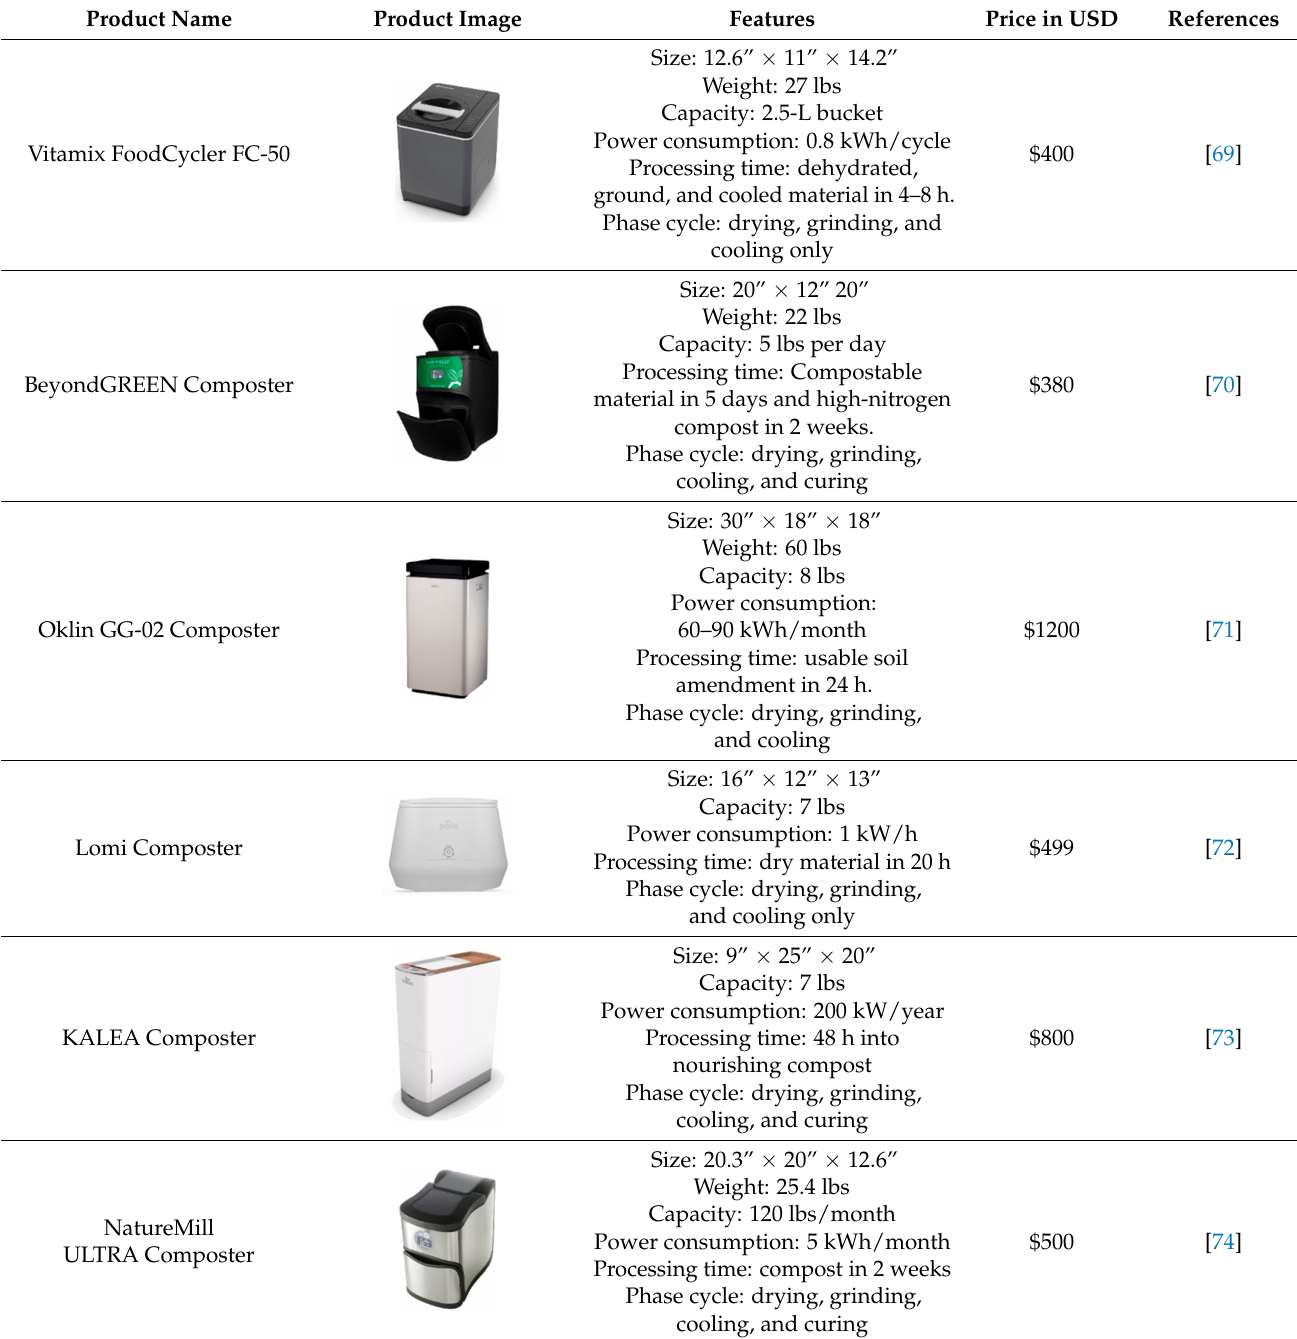
Table 3. List of some available electrical home composters in the